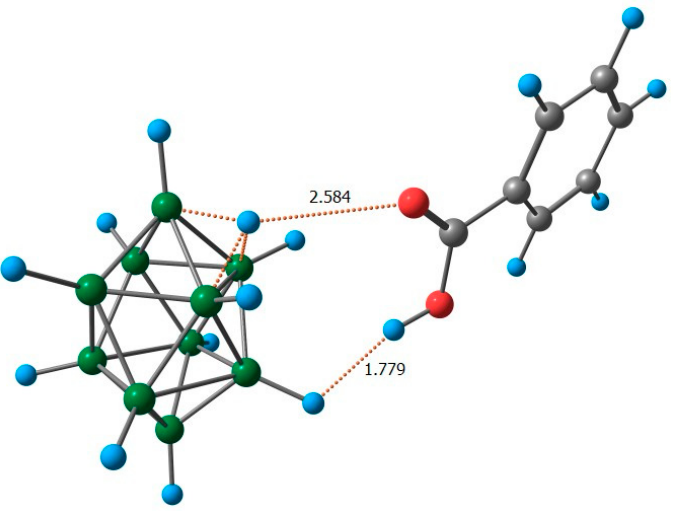
Figure 2. Structure of complex between [B 10 H 11 ] − and C 6 H 5 COOH. Length units—Å, ω B97X- D3/def2-TZVPP level of theory.